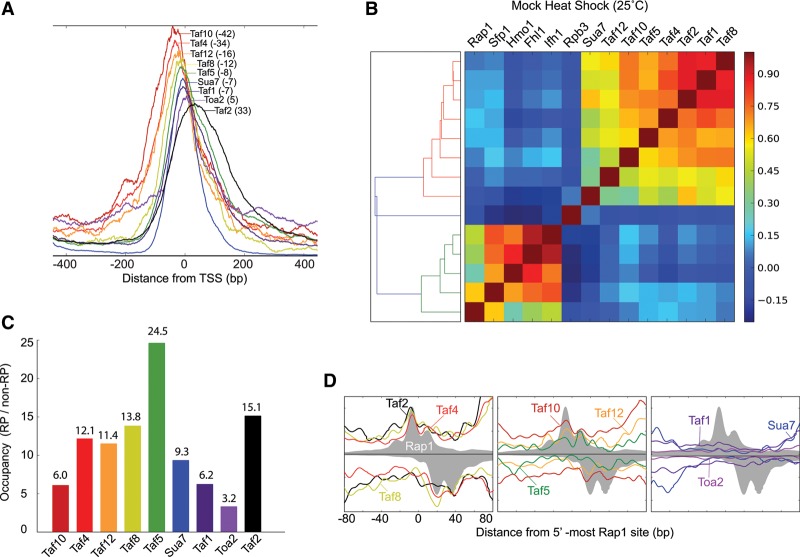
Spatial organization of TAFs in relation to TSS and Rap1. (A) Averaged frequency distribution of shifted tags for TAFs and general factors in relation to RPG TSSs. Peak distances from the TSS are shown in parentheses. Each trace is separately and linearly scaled on the Y-axis. (B) Heat map representing Pearson correlation values for the occupancy of proteins at RPGs. (C) Bar graph comparing the occupancy of Sua7, TAFs, and Toa2 at RPGs relative to non-RPGs. (D) Frequency distribution of unshifted tag 5′ ends for TAFs, Toa2, and Sua7 compared with the equivalent for Rap1 (filled gray plot) and oriented with the TSS to the right. Tags on the antisense strand are inverted.